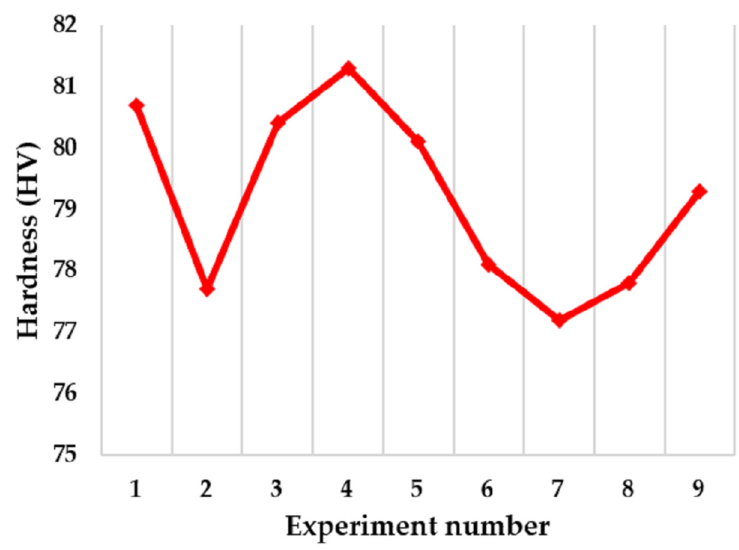
Figure 13. The average hardness values in the SZ of the nine samples.